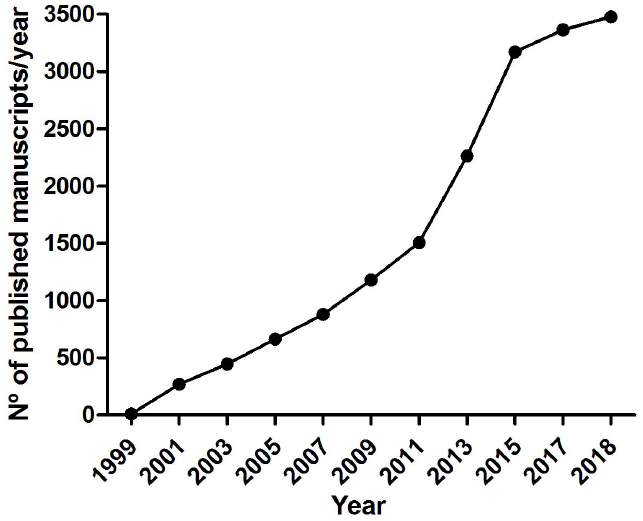
Figure 2. Number of scientific manuscripts on mesenchymal stem/stromal cells published over time. Timeline of published scientific articles about MSCs. The research was done in PubMed database using the terms “mesenchymal stem cell” OR “mesenchymal stromal